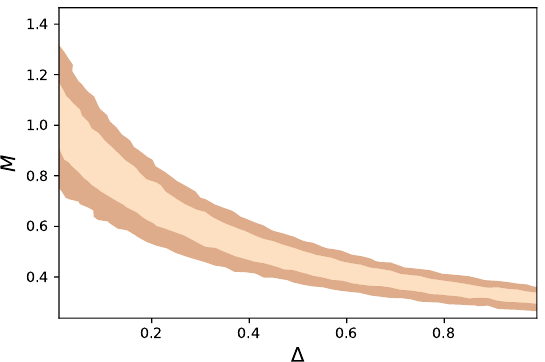
Figure 3. 1 σ and 2 σ parameter region consistent with M87 ∗ shadow